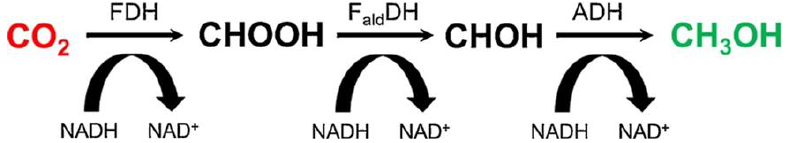
Figure 6. Biocatalytic transformation pathway of CO 2 to CH 3 OH via stepwise reverse enzymatic catalysis by FDH, F ald DH, and ADH [106].